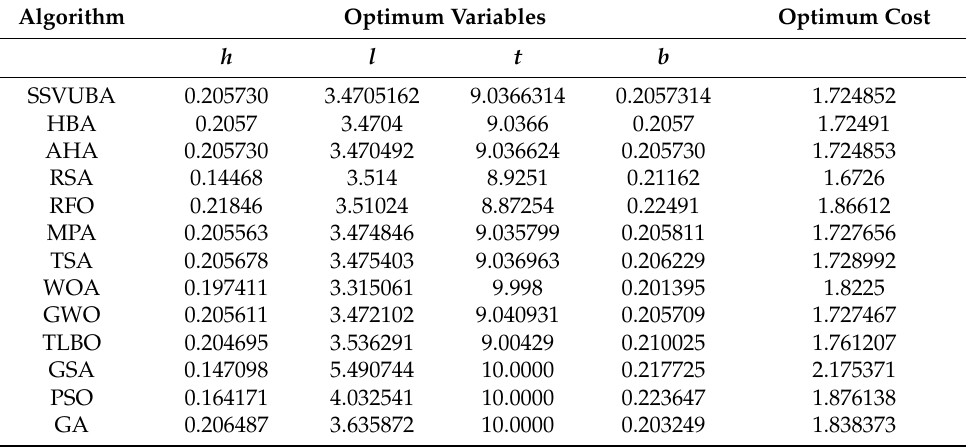
Table 14. Performance of optimization algorithms in the welded beam design problem.